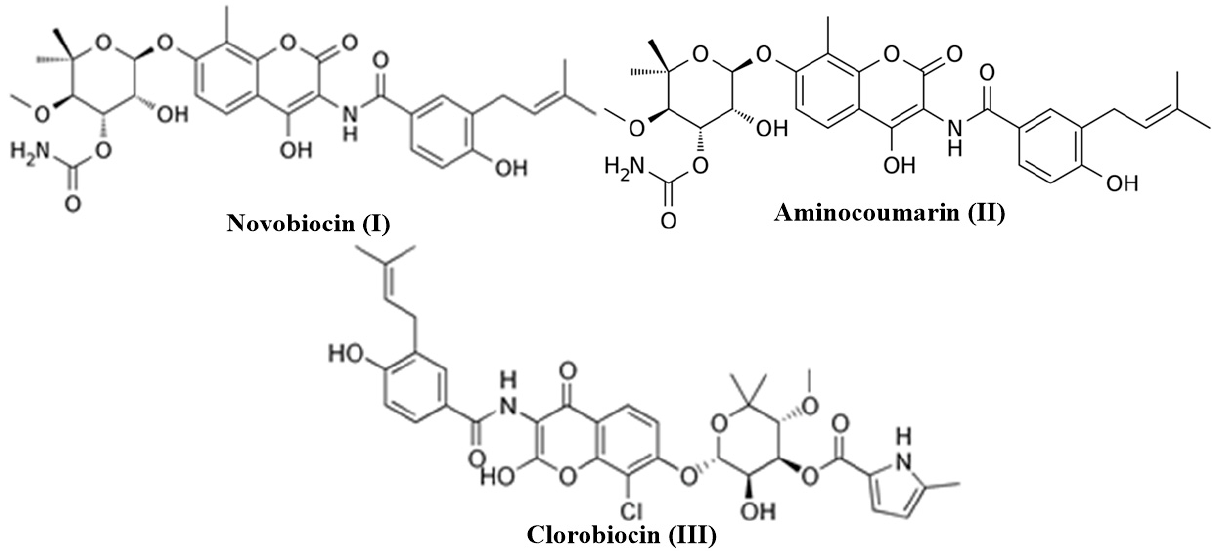
Figure 1. Clinically used coumarin-based antibiotic drugs.